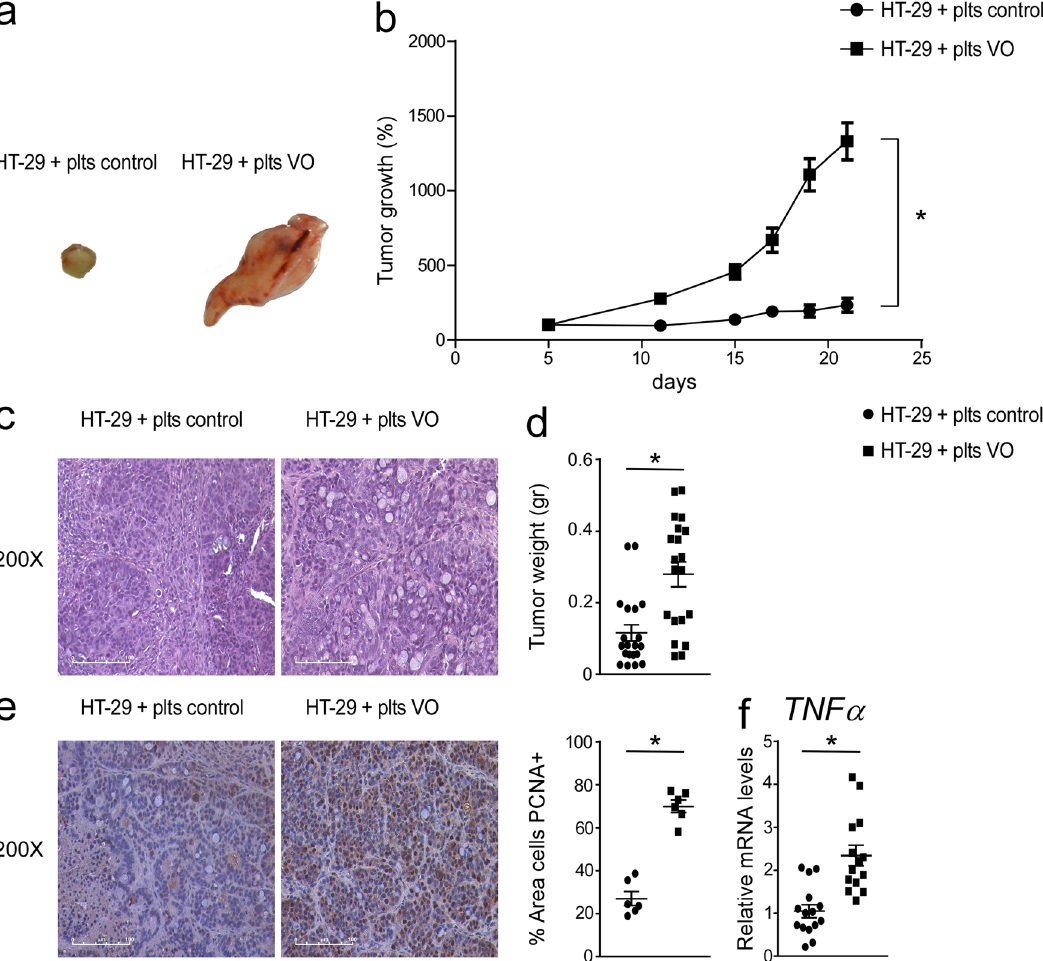
Fig. 1 Platelets isolated from visceral obesity (VO) patients increased tumor growth in xenograft tumor model. a Athymic nu/nu mice were injected subcutaneously with HT29 cells and platelets isolated from VO patient and control were administered directly into the tumor mass every 7 days. Gross morphology of HT-29 cells treated with platelets isolated from VO patients and controls ( n = 10 mice/group). The pictures were taken during the sacri fi ce with digital camera. b Tumor growth (%) curves showed high expansion of tumors injected with VO platelets ( n = 20 tumors/group). c Histology was assessed by H&E staining and was observed by light microscopy (magni fi cation, 200X). Representative specimens are shown. d Tumor weight (gr) was reported. e Paraf fi n-embedded tumor specimens from HT-29 cells inoculated with control platelets and HT-29 cells inoculated with VO platelets were immunoassayed with anti-PCNA antibody (200x magni fi cation). Representative specimens are shown. PCNA staining per fi eld was quanti fi ed by ImageJ software and displayed as percentage per fi eld ( n = 6 samples/group). f Gene expression analysis of TNF α in HT-29 cells inoculated with control platelets ( n = 15) and HT-29 cells inoculated with VO platelets ( n = 14). Cyclophilin was used as a housekeeping gene to normalize data. The results are shown as mean ± SEM in scatter plots. Statistical signi fi cance ( P < 0.05) was assessed by student ’ s t